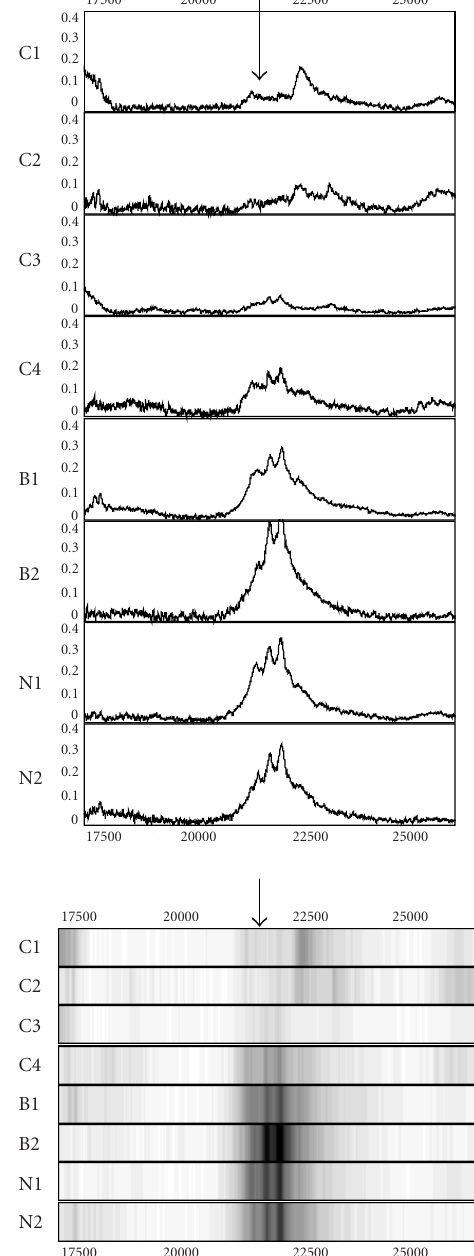
Figure 7. Spectra (top) and grey-scale or gel views (bottom) of the peaks (arrows) forming the splitting rules. The protein peak was detected on the SAX surface. The peak appears to be down- regulated in the